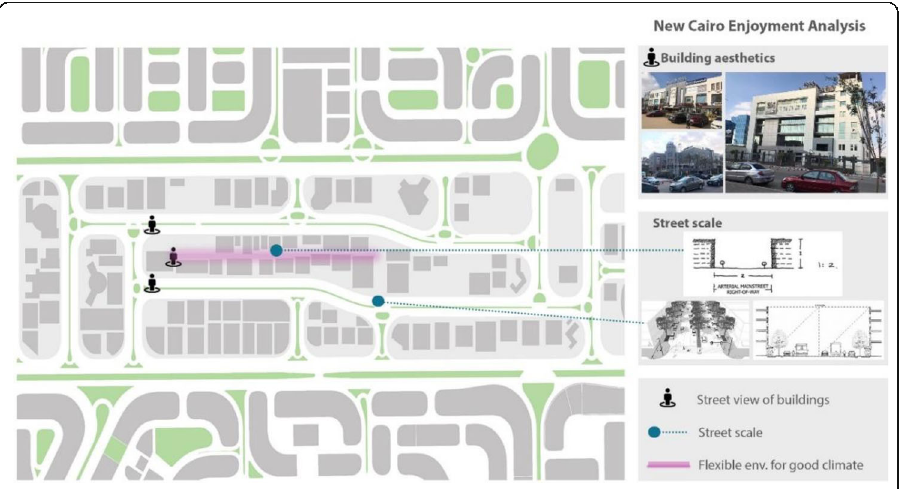
Fig. 13 New Cairo map, analysis of enjoyment aspect in the Banks Street zone